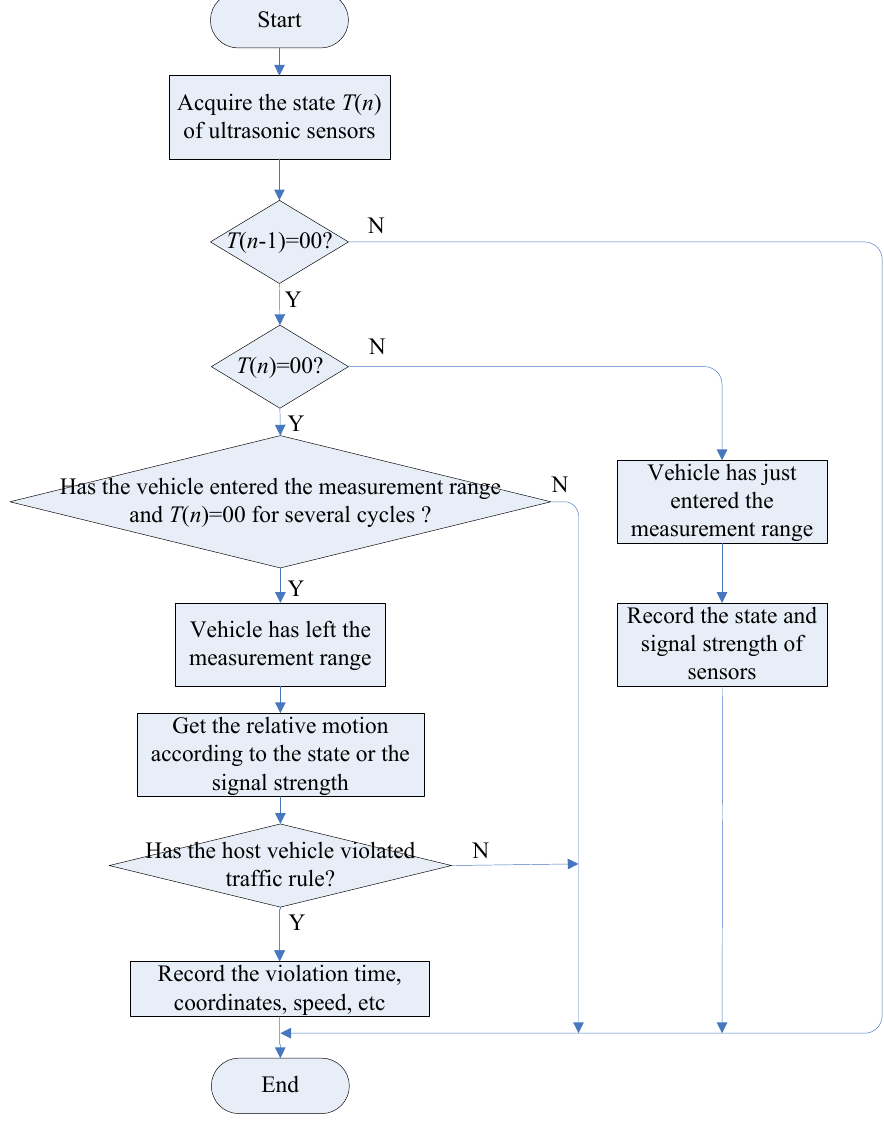
Figure 5. Flowchart of the TRV detection and counting